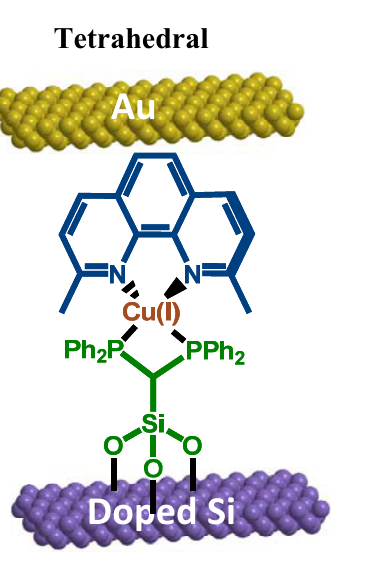
Figure 4. The schematic structure of the molecular rotor device composed of a Bisphenanthroline (bisP) stator, a copper metal axle, and a diimine rotator. The diimine ligand on top, 2,9-dimethyl-1,10-phenanthroline, rotates upon reduction and oxidation in the direction as illustrated with